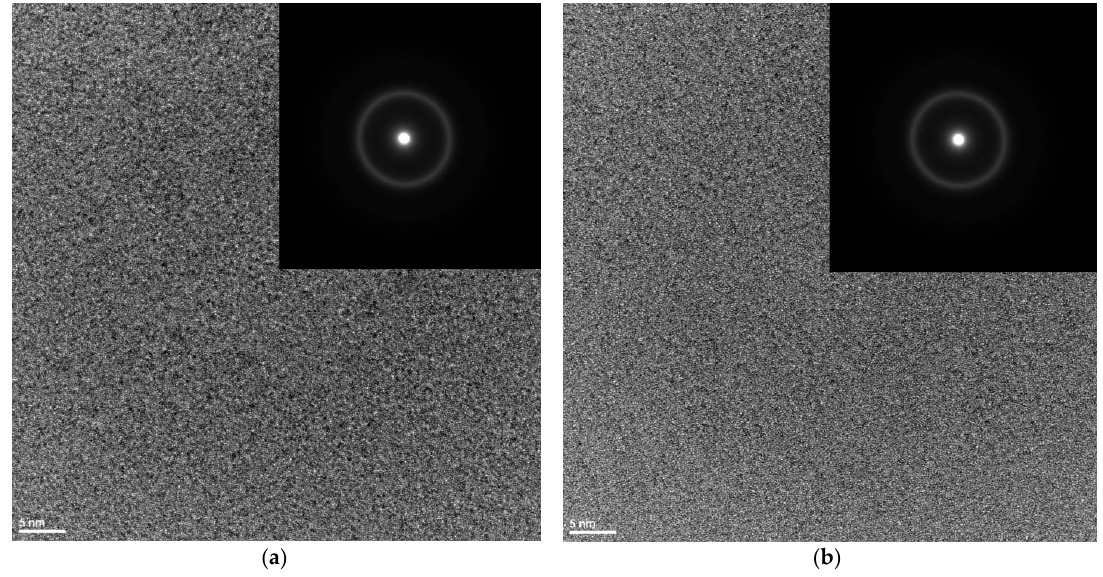
Figure 4. High-resolution transmission electron microscopy (HTREM) images and the selected area electron diffraction (SAED) of ( a ) Fe 36.00 Co 36.00 B 19.00 Si 5 Nb 4 and ( b ) Fe 35.75 Co 35.75 B 18.90 Si 5 Nb 4 Cu 0.6 amorphous alloys in rod form with the diameter of 1.5 mm.